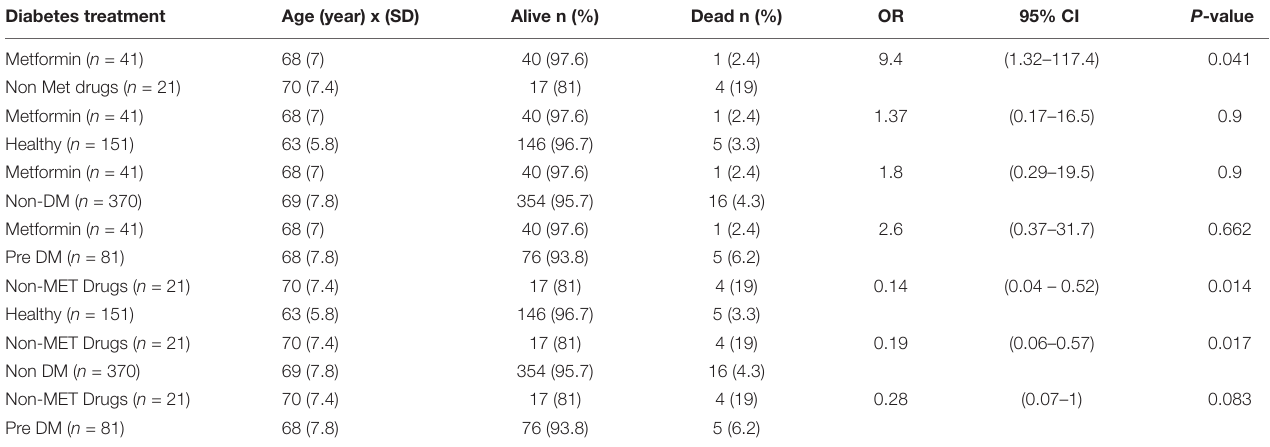
TABLE 4 | Five-years follow up survival